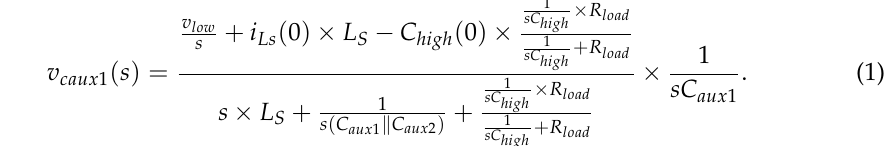
Figure 16. The Laplace equivalent circuit from step-down mode to step-up mode.